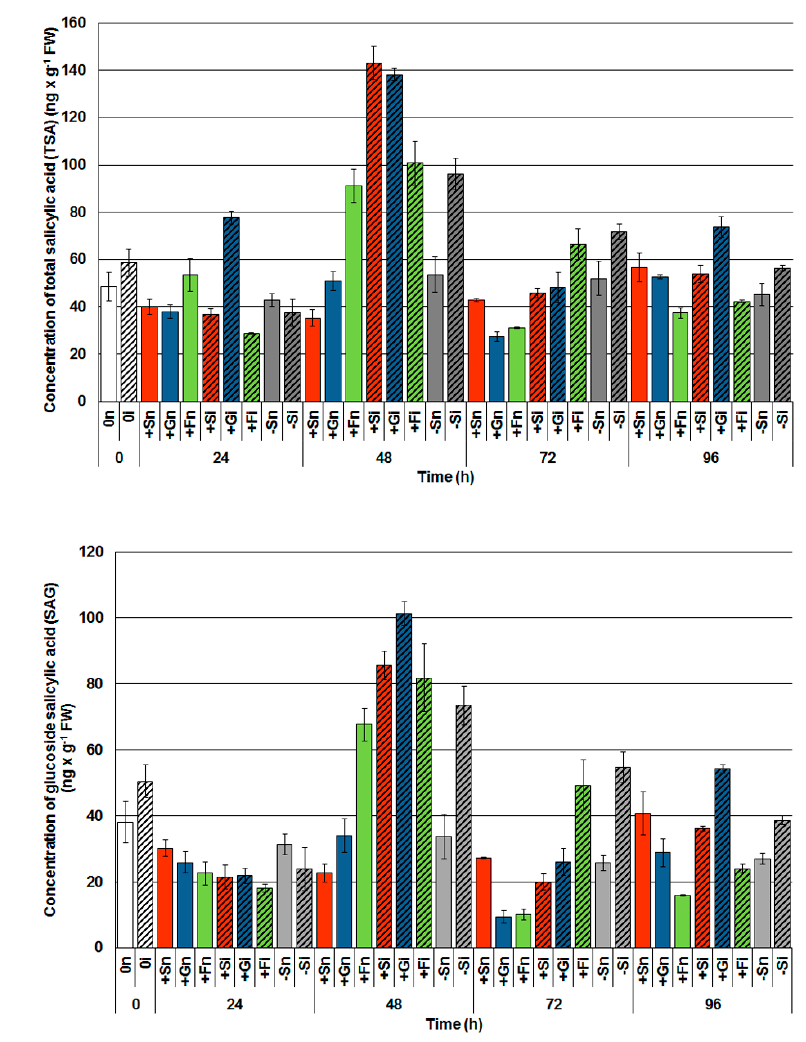
Figure 1. E ff ect of sucrose, glucose and fructose on the accumulation of free salicylic acid (SA; ( A )) salicylic acid glucoside (SAG; ( B )) and total salicylic acid (TSA; ( C )) in in vitro cultured embryo axes of Lupinus luteus infected with Fusarium oxysporum f. sp. lupini . A summary of the statistical significance of di ff erences between the average values of each pair at p < 0.05 can be found in the Supplementary Files (Tables S1–S3).